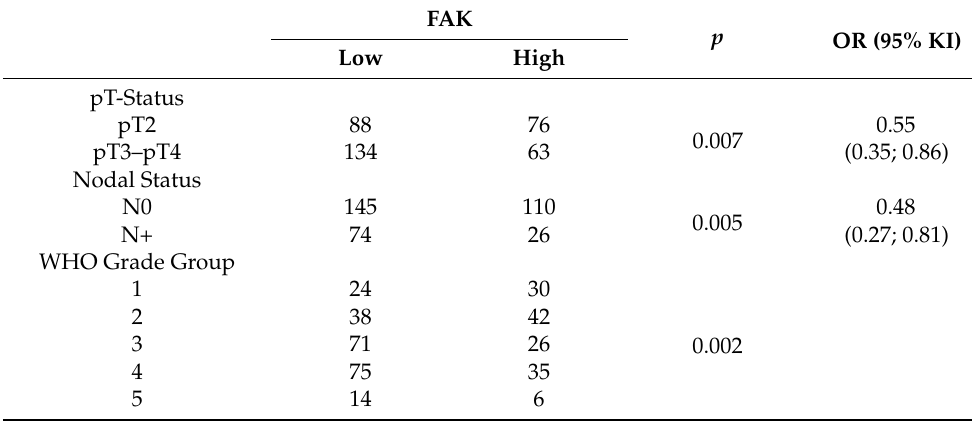
Table 2. Association between FAK-expression and common pathological